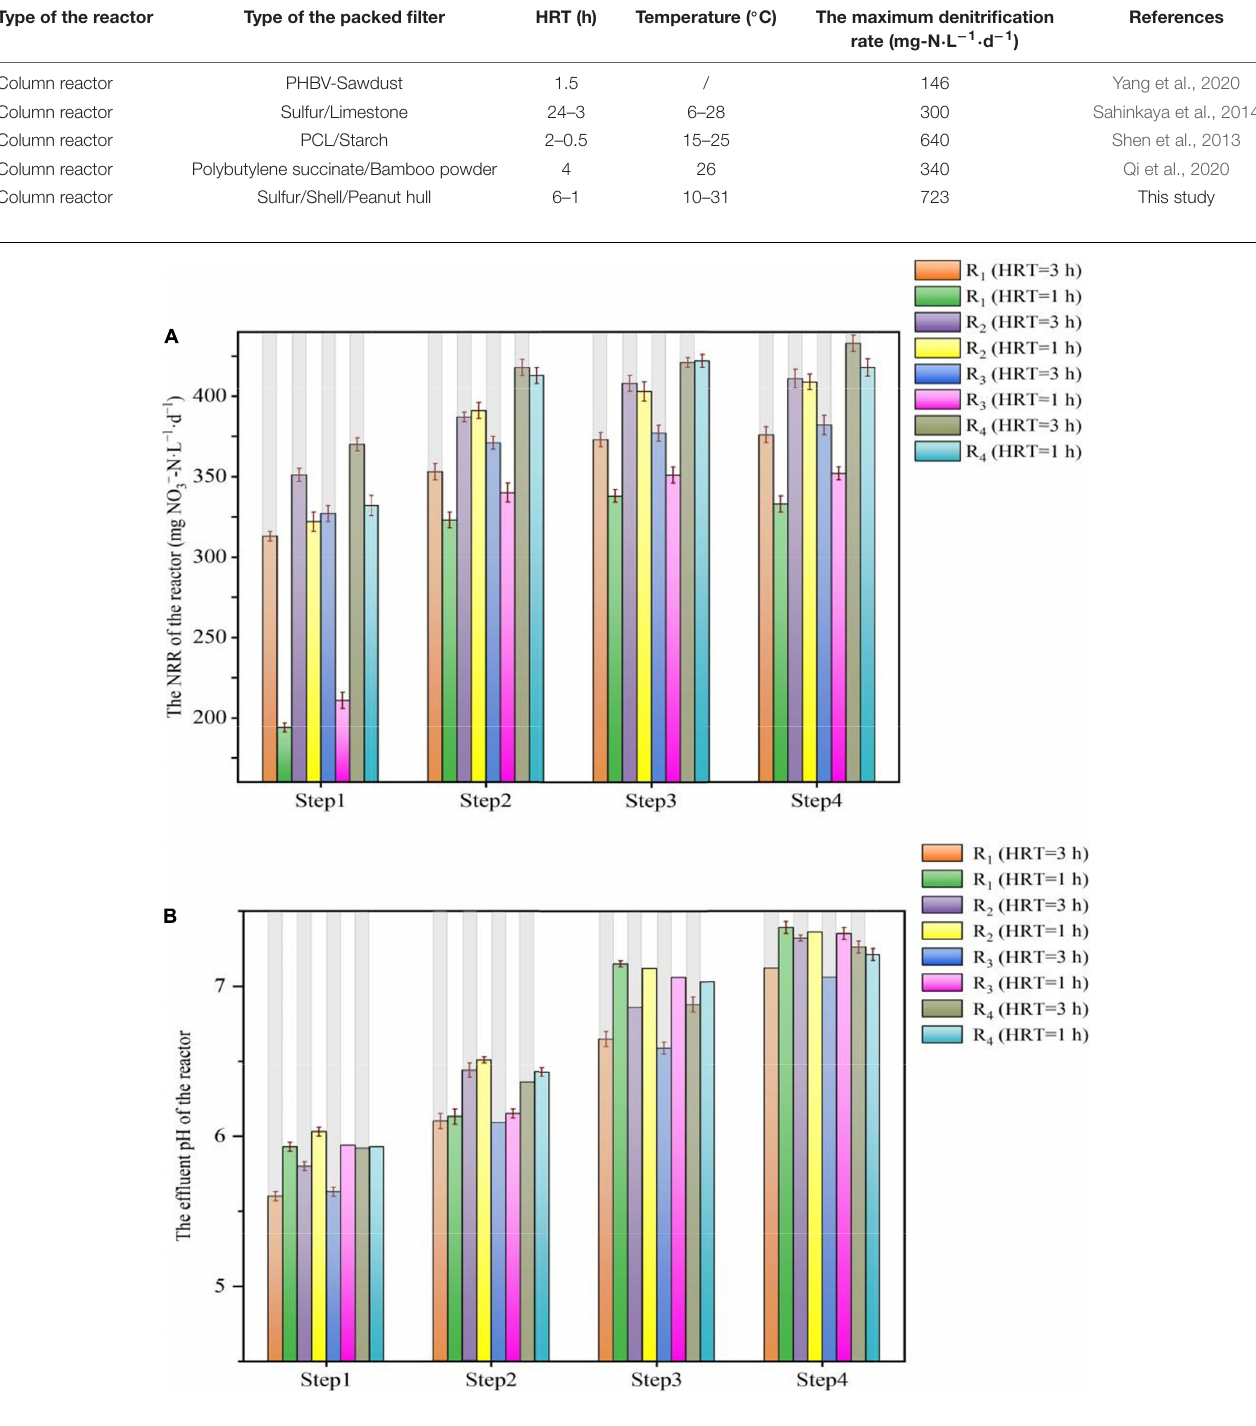
FIGURE 3 | Variations in NRR and effluent pH value in period 7 of the R 1 –R 4 reactors. (A) NRR; (B) effluent pH